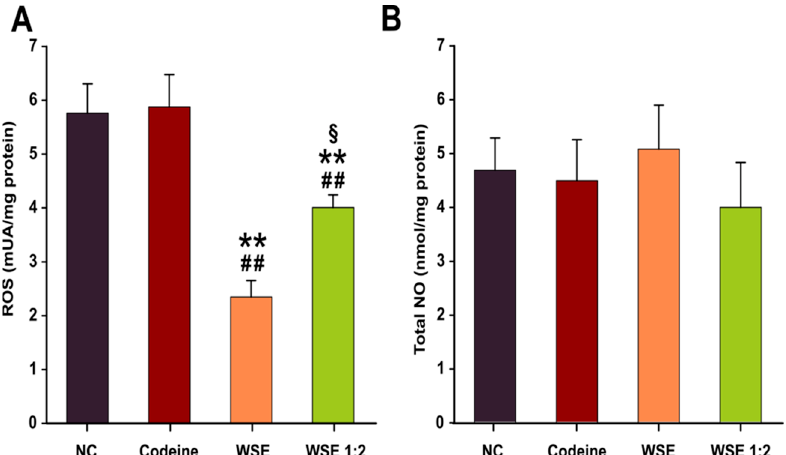
Figure 2. The effects of the treatments on reactive oxygen species ( A ) and total nitric oxide ( B ) in lung tissue homogenates. Values are expressed as mean ± SEM ( n = 6). ** p < 0.01 compared to NC; ## p < 0.01 compared to positive control (Codeine); § p < 0.05 between the two concentration of WSE. Statistical significance differences in datasets were determined with one-way ANOVA with the Holm-Sidak post hoc test. NC—negative control; NO—nitric oxide; ROS—reactive oxygen species;